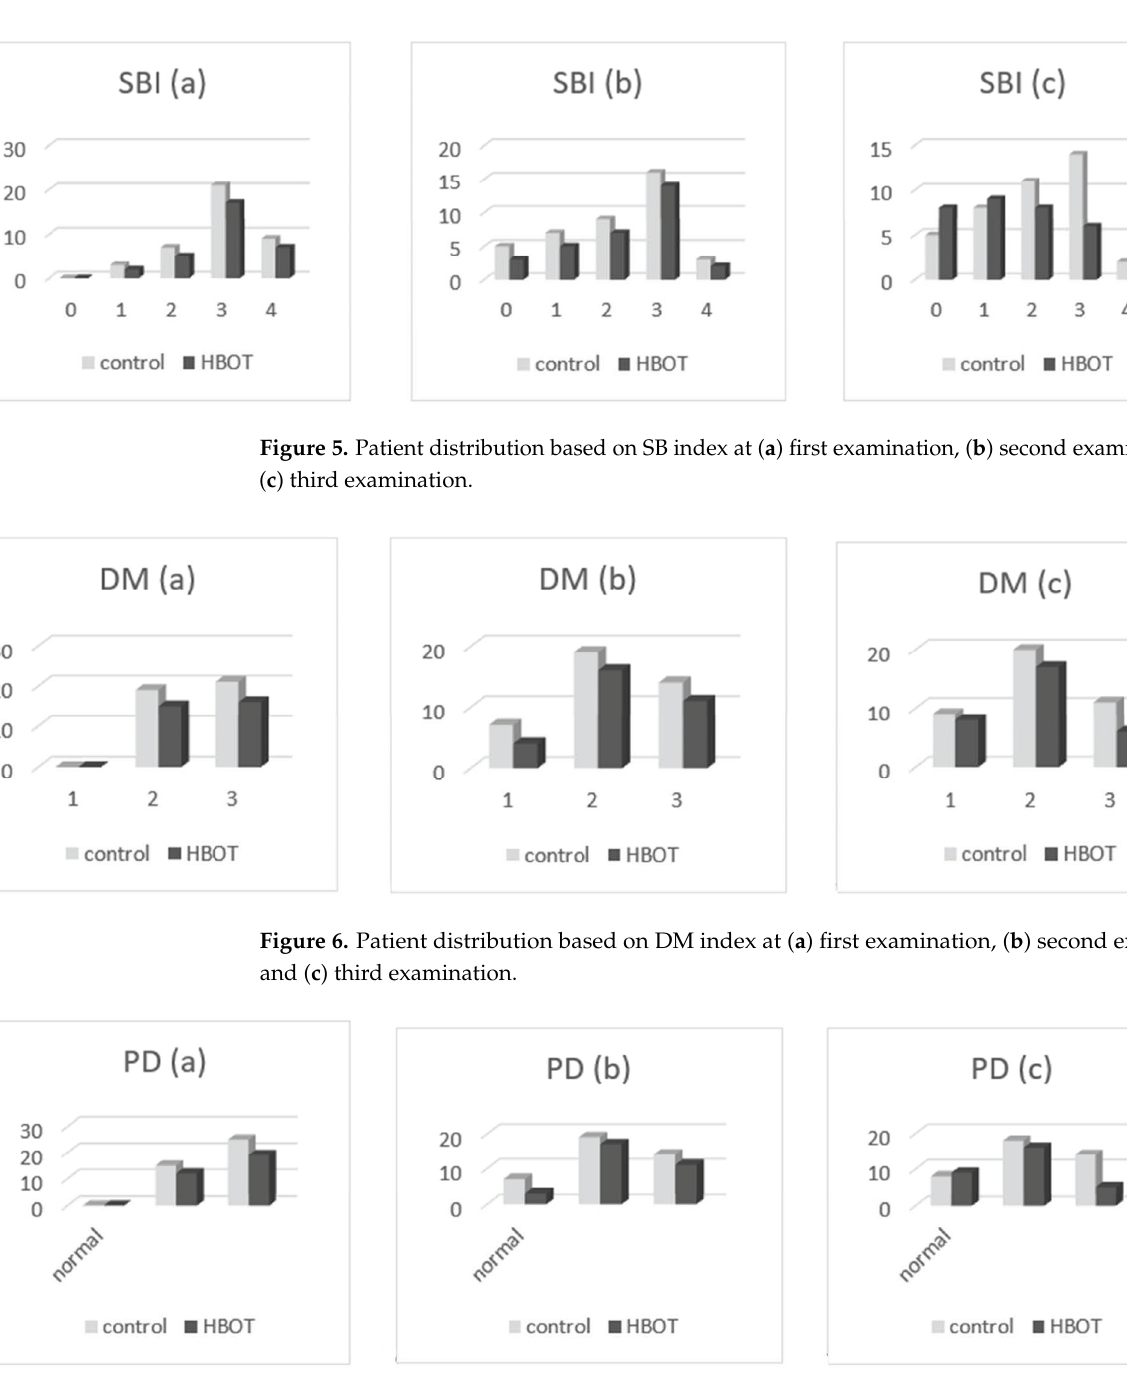
Table 5. Chi-Square test p -values for test differences between groups, for all variables, at all “three levels of investigation”.